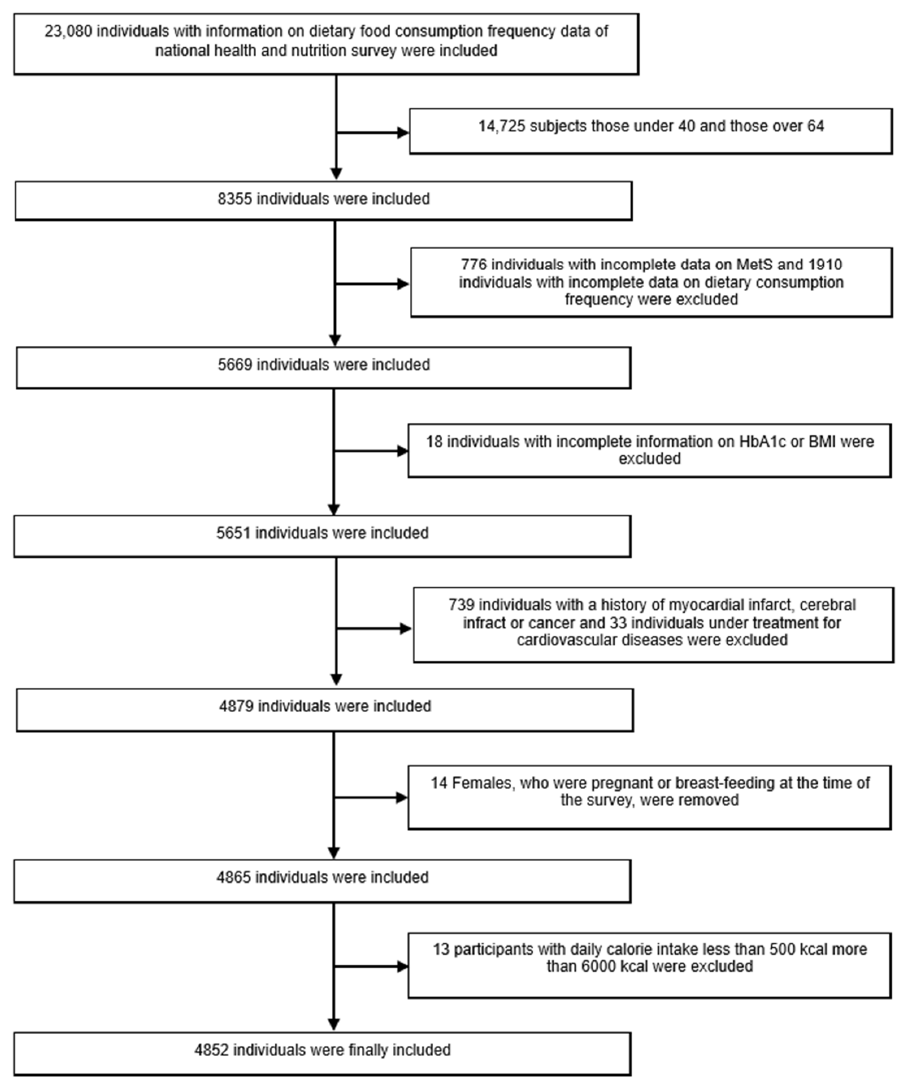
Figure 1. The population of the